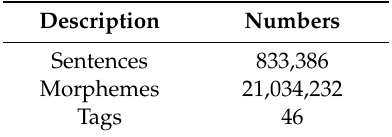
Table 3. Summary of the 21st century Sejong corpus.